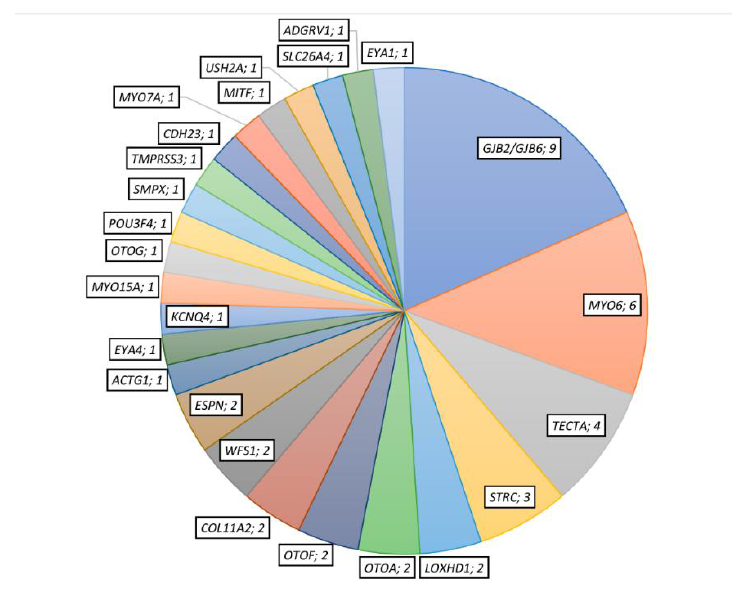
Figure 1. Number of diagnosed patients with putative disease-responsible variants in each represented gene. Table 2. Disease Causing Variants Detected and Clinical Data of the Diagnosed Patients. (A) Patients Diagnosed with Autosomal Recessive Deafness